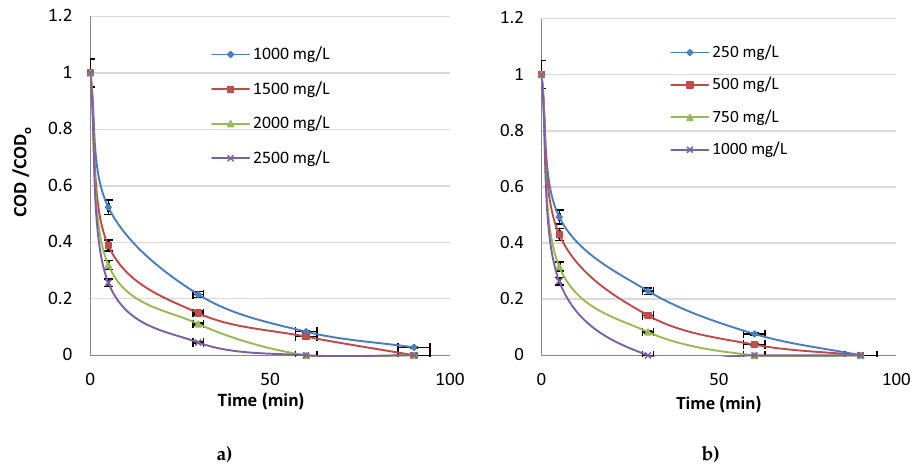
Figure 3. Effect of electrolyte type and concentration on chemical oxygen demand (COD) decrease with Sn:Sb:Ni: 500:8:1 anode ( a ) with NaCl and ( b ) with KCl addition (pH 8 and I: 50 mA cm −2 ).